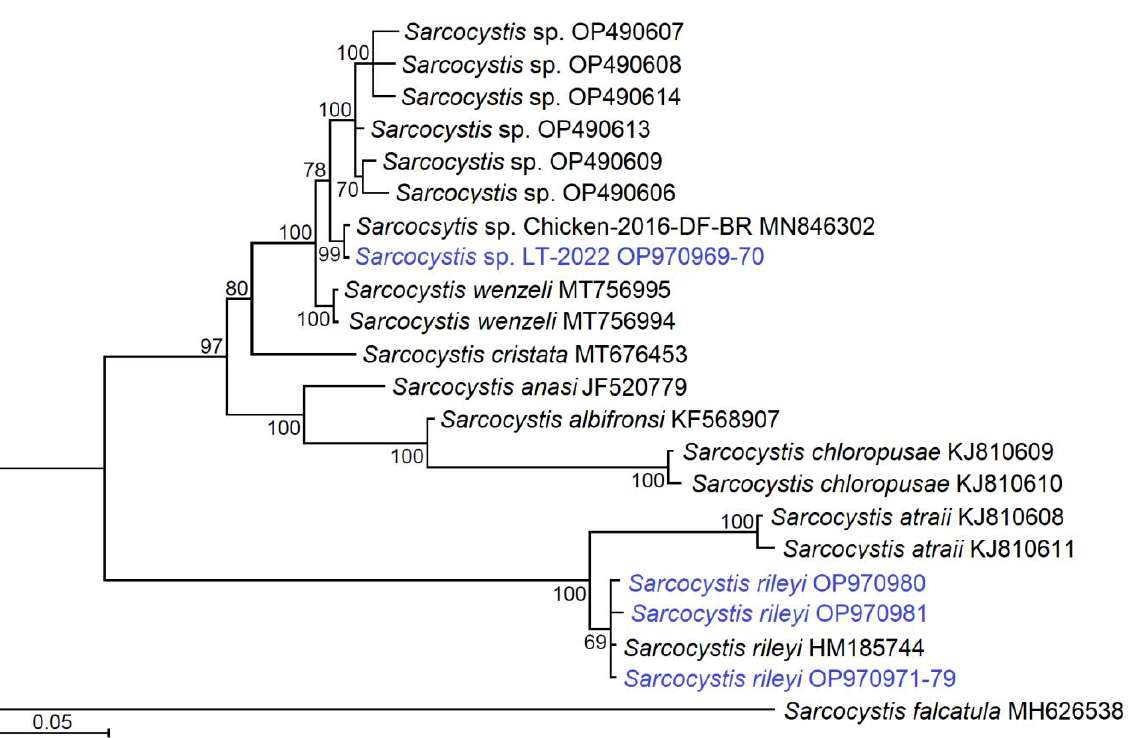
Figure 3. The phylogenetic tree of the Sarcocystis species based on ITS1 sequences and Bayesian inference. The multiple-sequence alignment contained 609 aligned nucleotide positions; the Kimura’s two-parameter substitution model (K2P) [37] was used for analysis. The tree was rooted on S . falcatula and scaled according to branch length. The posterior probability values supporting branching are shown next to the branches. The sequences determined in the present study are presented in blue.